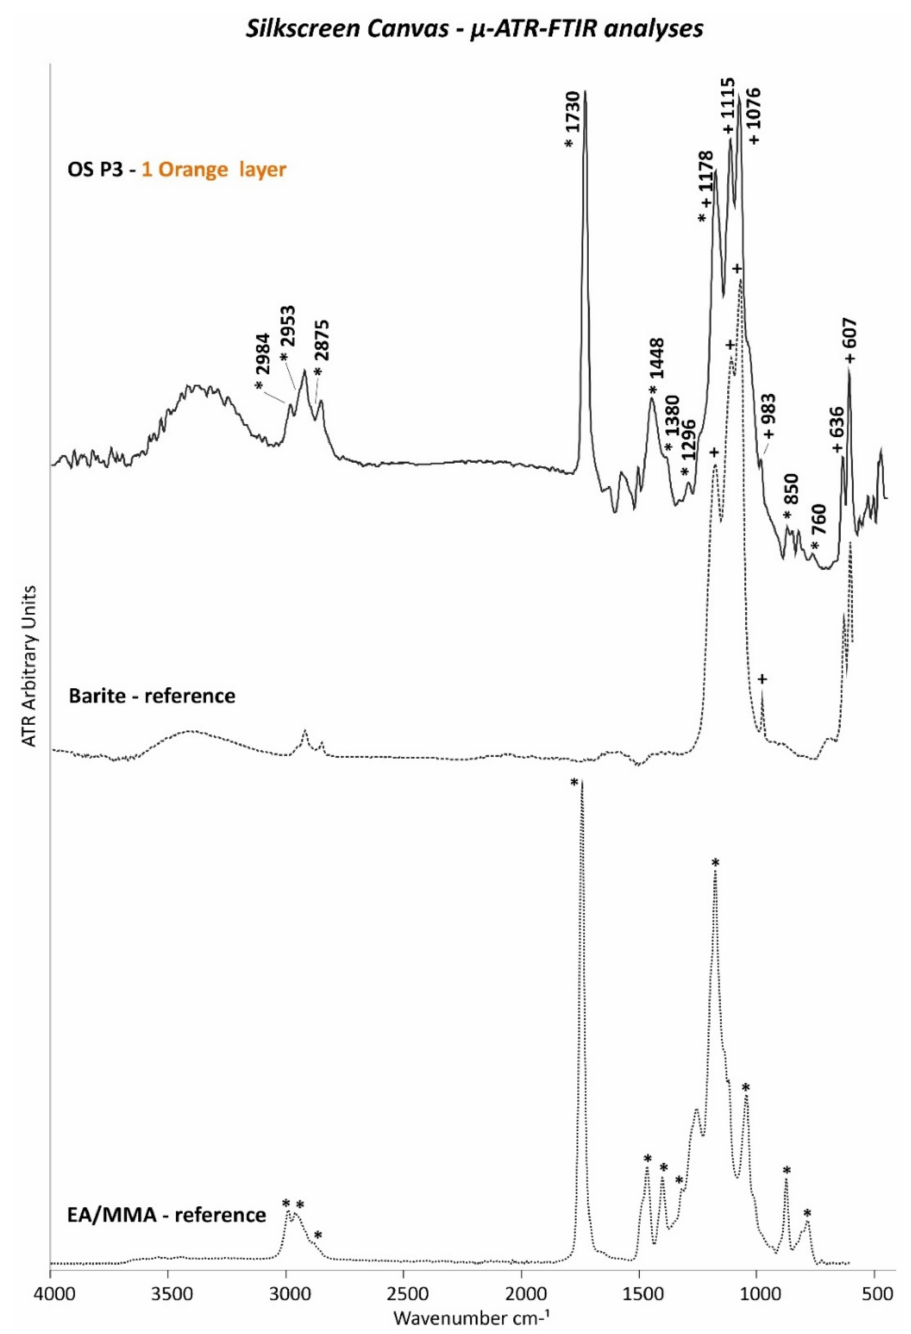
Figure 14. ATR spectra of orange layer 1 of OS P3. The ATR spectra of the EA/MMA (*) and barite (BaSO 4 ) (+) references are also